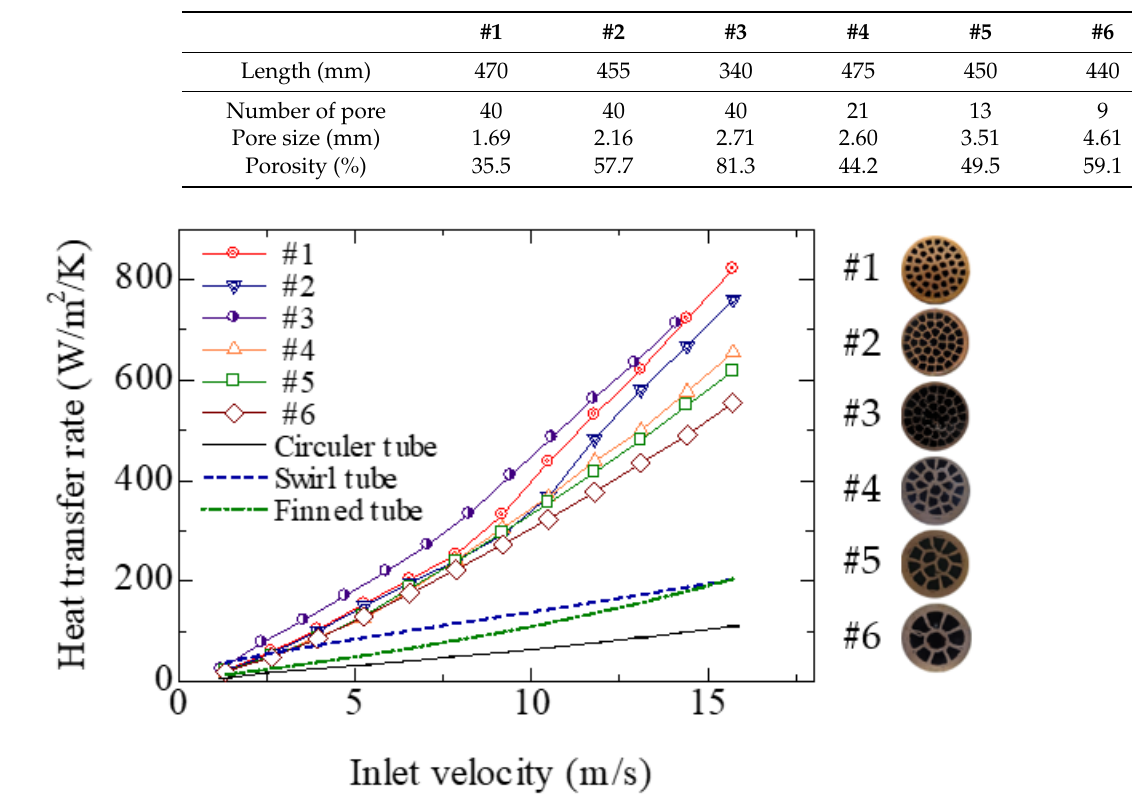
Table 1. Specifications of porous tubes.